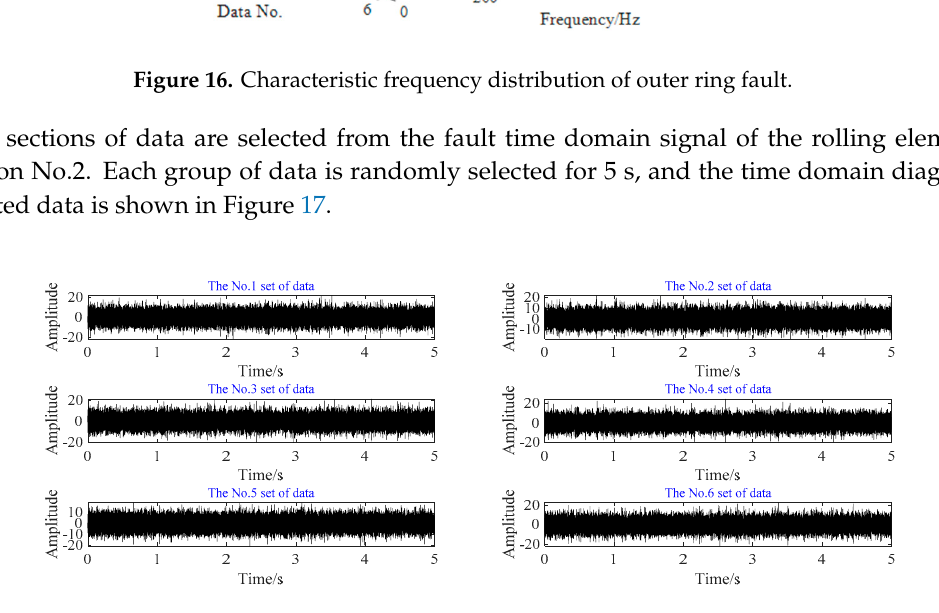
Figure 17. Sectional time domain diagram of rolling element fault.